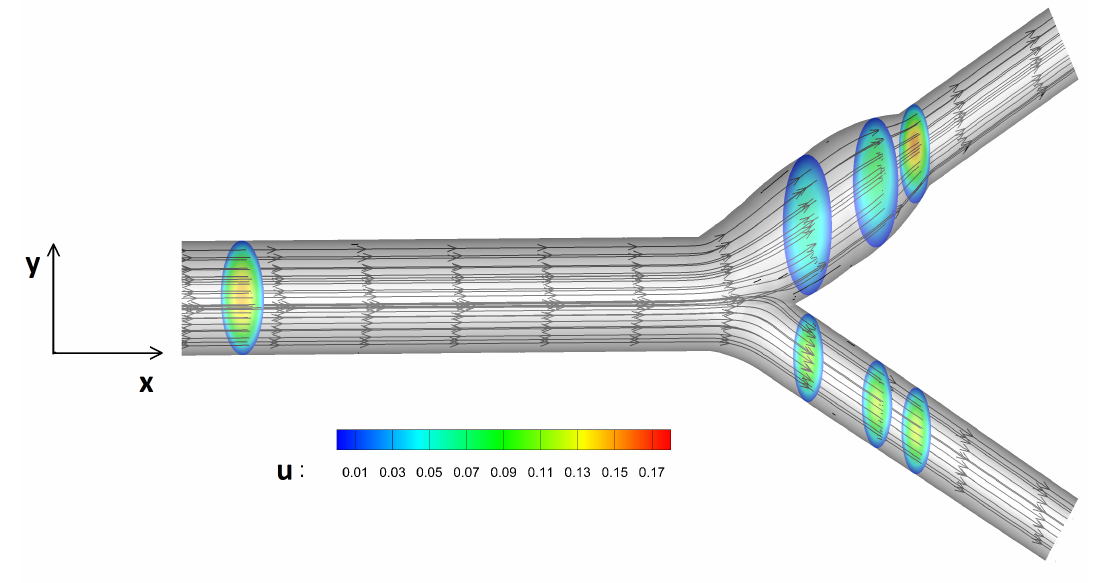
Figure 6. Streamlines and velocity contours in selected normal planes for m =